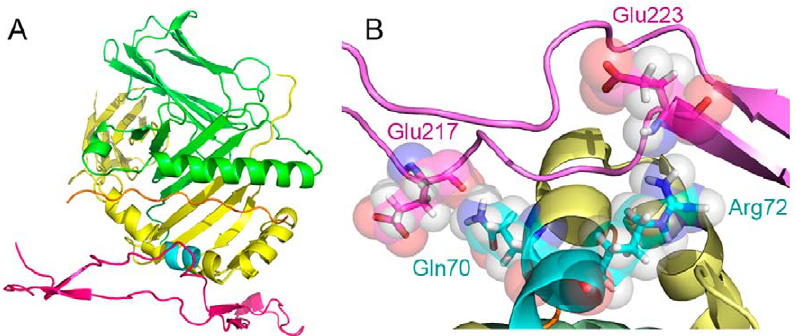
Figure 5. Proposed CRT-SE interaction model. A . A SE-positive HLA-DR4 molecule (PDB ID: 2SEB) interacting with the SE-binding site in the CRT P-domain. The HLA-DR a chain is shown in green, HLA-DR b chain is in yellow, the SE is in cyan, CRT P-domain is in purple, and the groove peptide is shown in orange. B . A closer view of the interactions between CRT Glu 217 and SE Gln 70 and between CRT Glu 223 and SE Arg 72 .